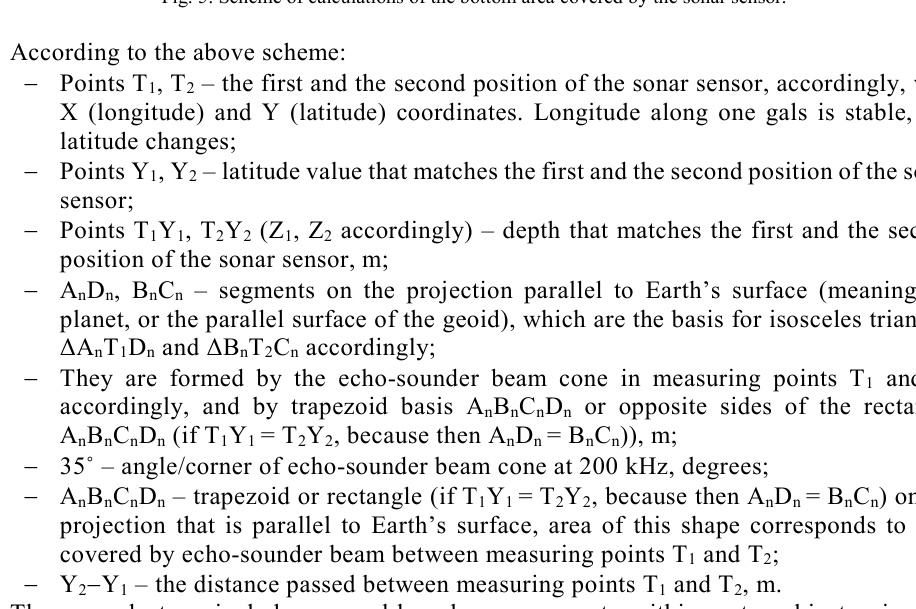
Fig. 5. Scheme of calculations of the bottom area covered by the sonar